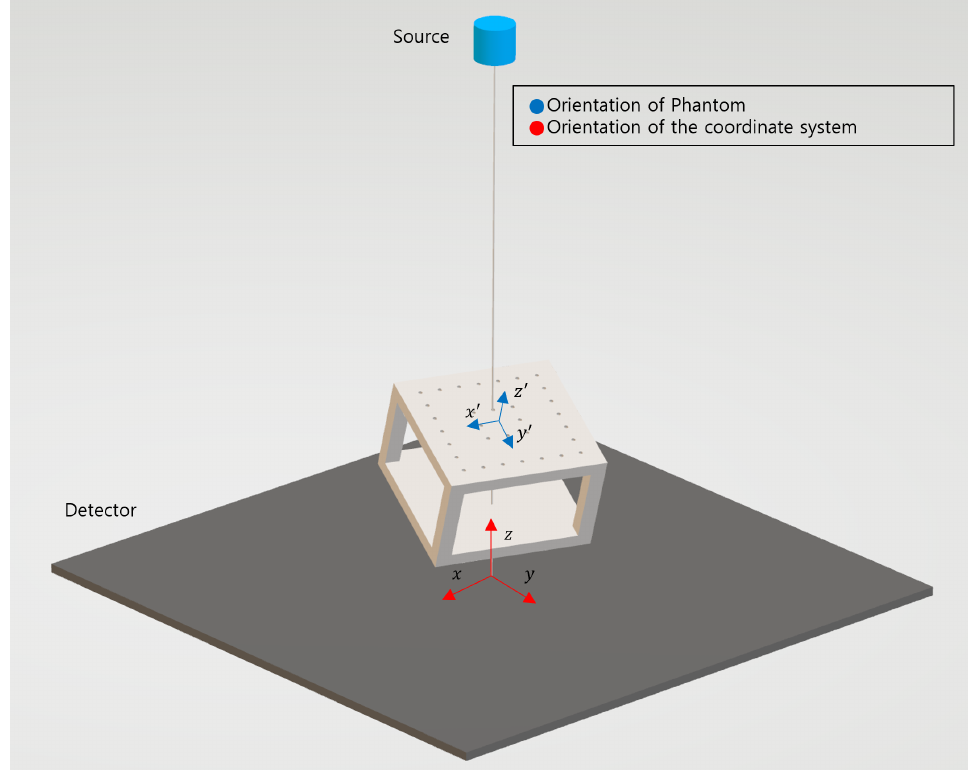
Figure 3. Coordinate system used in the calibration; the red axes show the world coordinate system, and the blue axes represent the orientation of the